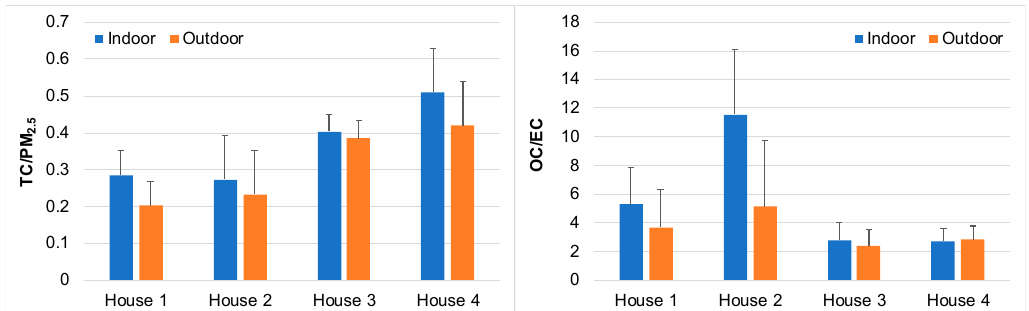
Figure 2. Ratios between total carbon (TC = EC + OC) and PM 2.5 and between organic carbon and elemental carbon.